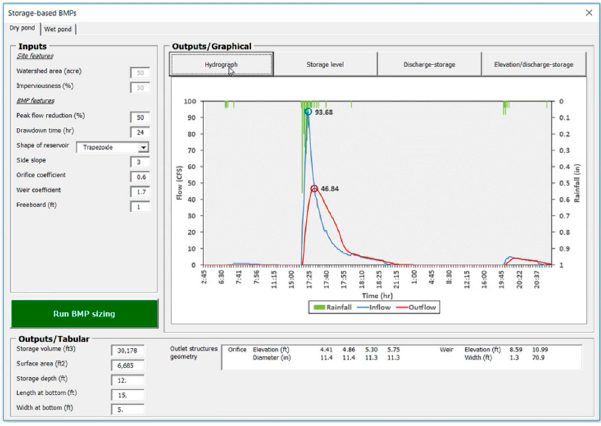
Figure A19. Output hydrograph for storage-based BMPs.